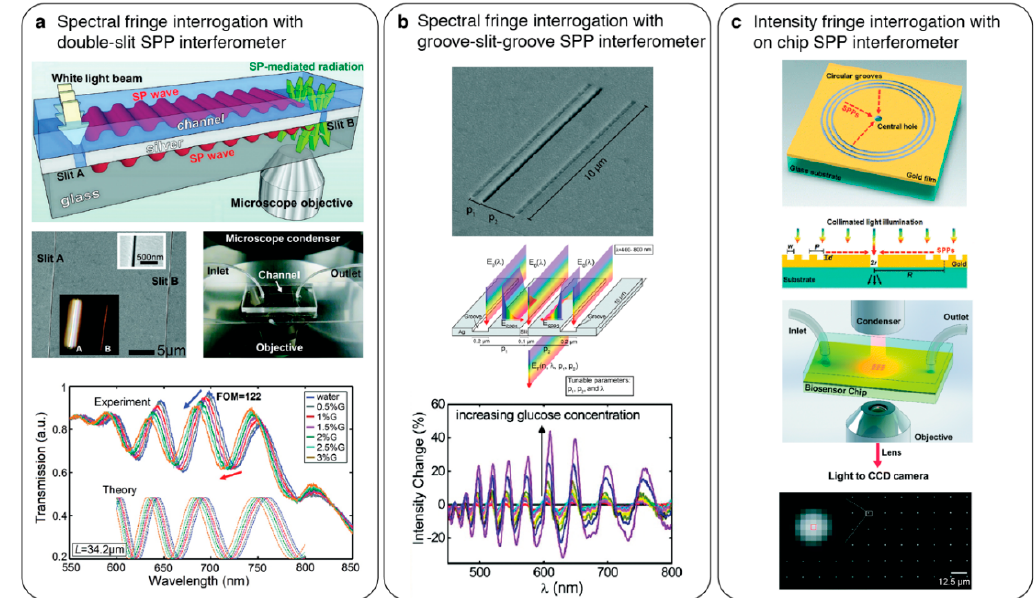
Figure 10. On-chip surface plasmon polariton interferometry. ( a ) (top) Schematic showing an on-chip Mach–Zehnder interferometry configuration. Nanoslit coupled propagating plasmons on the sensing channel and reference substrate interfere at the second slit where an objective collects the scattered light and fringe analysis is performed by a spectrometer. (middle) SEM showing the nanoslits and photograph of integrated microfluidic chip. (bottom) Spectra showing fringe shift as the refractive index of the sensing media increase. Adapted with permission from [98] Copyright 2011 American Chemical Society; ( b ) (top) SEM of a groove-slit-groove planar plasmonic interferometer where the groove distances to the slit are uneven. (middle) Schematic showing the working principle of plasmonic interferometer. Di ff ractively coupled surface plasmons at the grooves counter-propagate and interfere with the free-space propagating light at the slit where the transmitted light carries the sensing information. (bottom) Plot shows intensity changes in the fringe shifts as the top media refractive index increases. Adapted with permission from [99] Copyright 2012 American Chemical Society; ( c ) (top) intensity interrogating surface plasmon interferometry implemented by circular grooves and central hole geometry. (middle) Schematic showing collinear optical path with a monochromatic illumination probing the fringe shifts. (bottom) Bright-field image recorded by a CCD camera showing a large array of interferometers. Reproduced from [100,101] with permissions from The Royal Society of Chemistry.